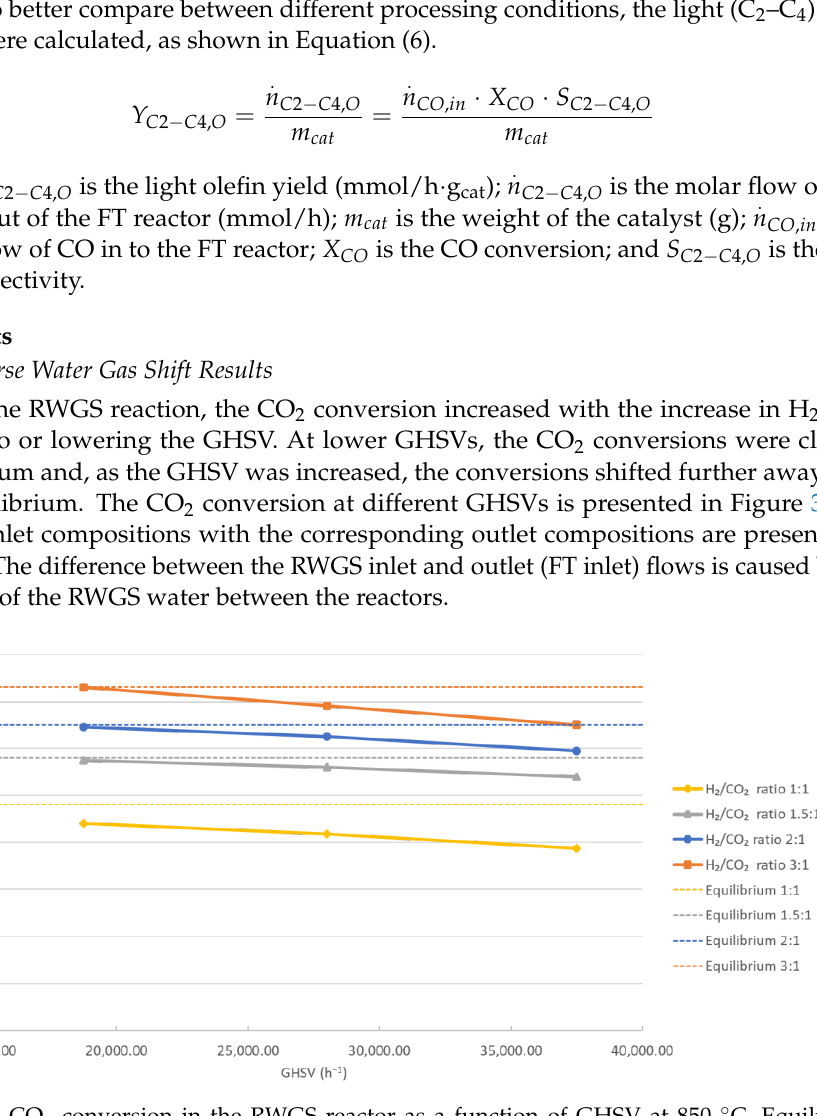
Figure 3. CO 2 conversion in the RWGS reactor as a function of GHSV at 850 °C. Equilibrium conversions showed as dashed lines. Equilibrium concentrations were calculated with Aspen Plus v11. Dashed lines are only for illustrative purposes. Table 2. RWGS inlet composition with the corresponding RWGS outlet (FT inlet) composition after the removal of